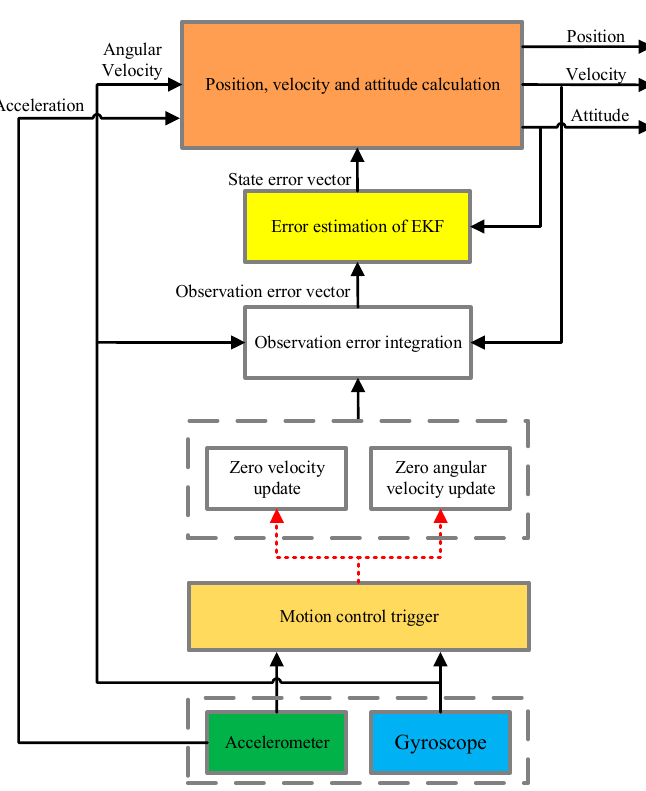
Figure 7. Flow diagram of the inertial navigation.